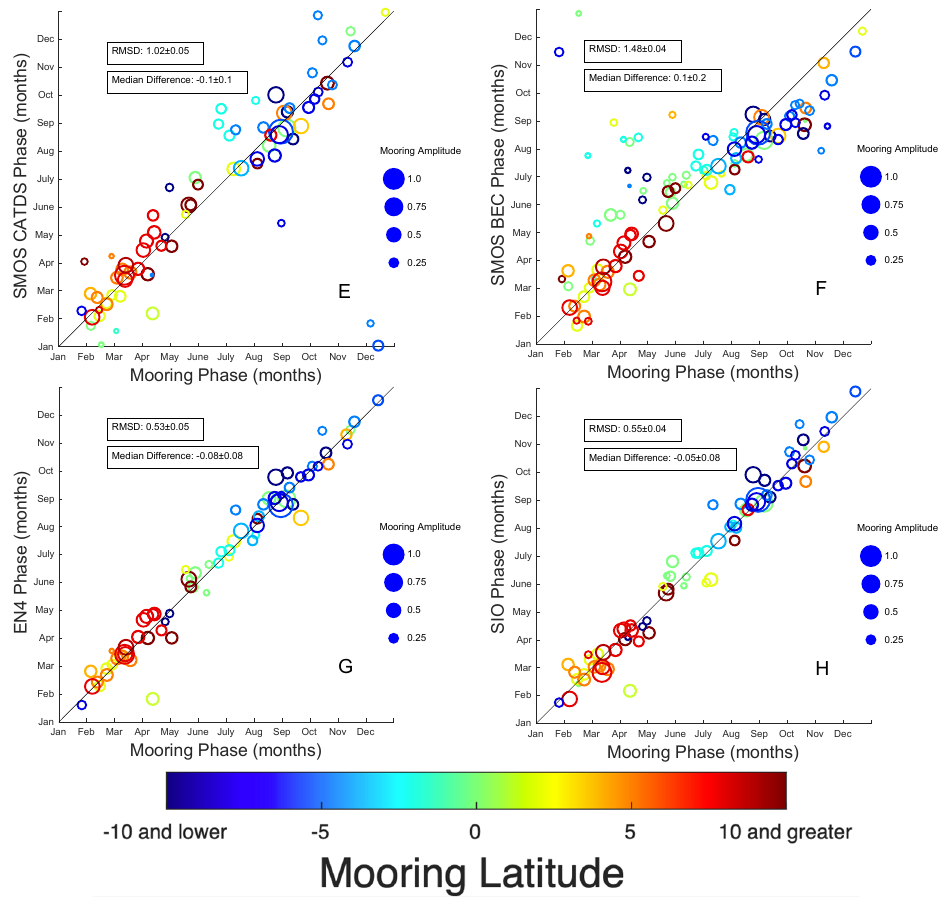
Figure 7. Scatterplots of first harmonic comparison product phase (month of maximum SSS) vs. mooring phase. Each symbol is for one mooring, with symbols plotted only where there is a significant annual fit for both the moorings and the